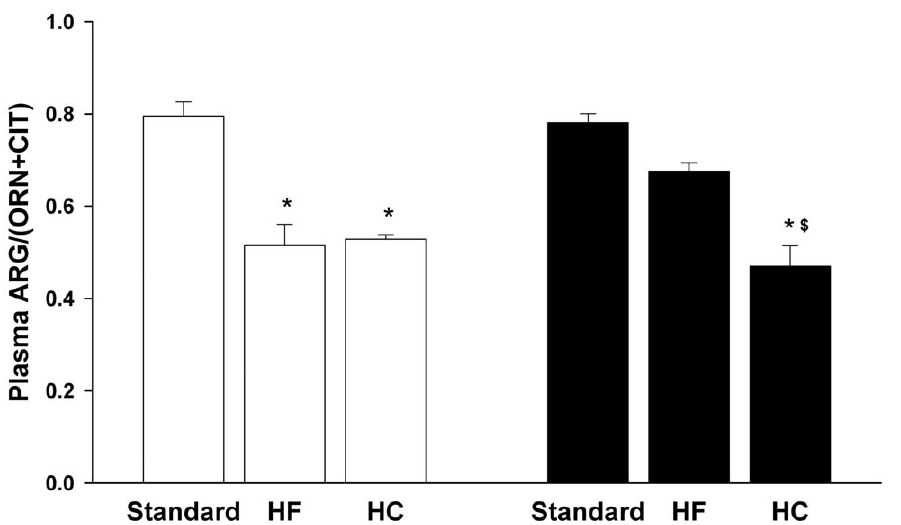
Figure 5. HF and HC diets reduce global arginine bioavailability. Values are means 6 SE for n=3–4 in each group. Abbreviations: ARG, arginine; ORN, ornithine; CIT, citrulline. Symbols are defined in Figure 2 legend.